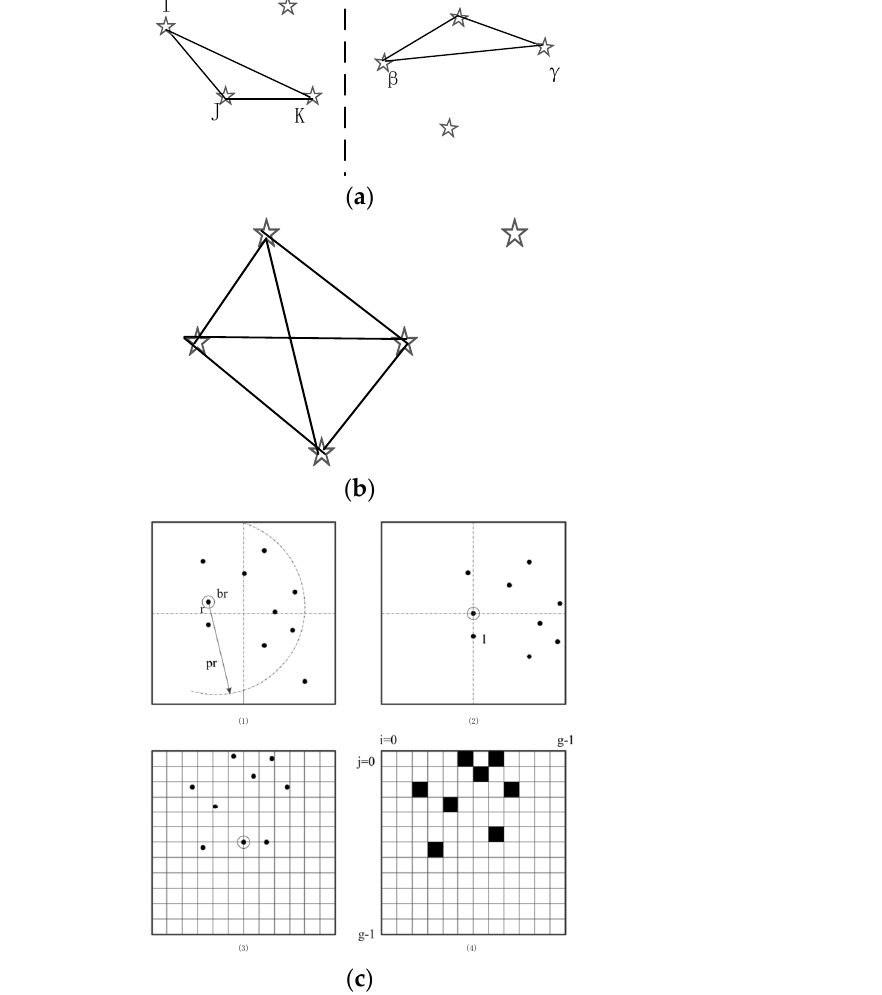
Figure 1. Schematic diagram of several different star map recognition algorithms. ( a ) Diagram of the triangulation algorithm. ( b ) Diagram of the pyramid algorithm. ( c ) Diagram of the grid algorithm.